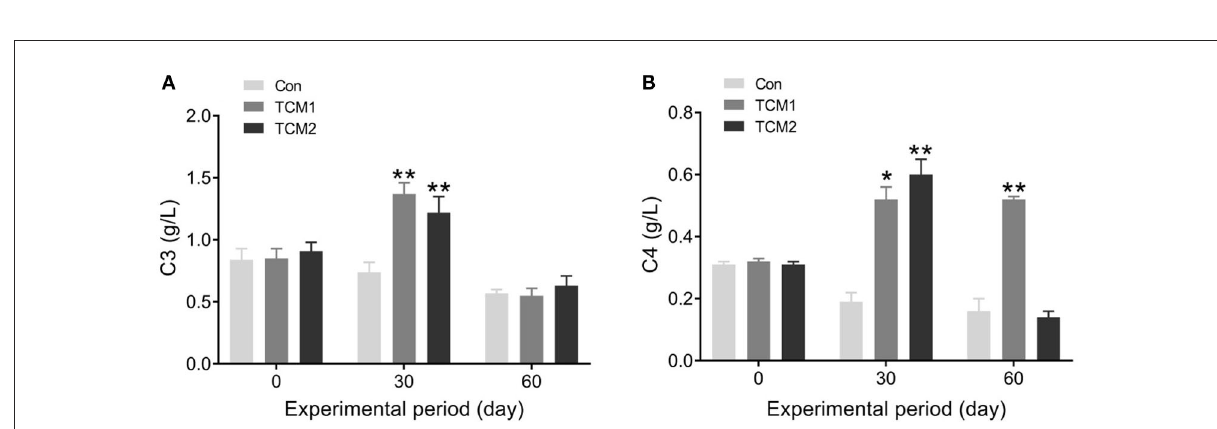
FIGURE2 Effect of TCM1 and TCM2 on the levels of serums C3 and C4 in finishing swine. (A) The serum C3 level. (B) The serum C4 level. “*” indicates significant difference compared with control group (* P < 0.05 and ** P <